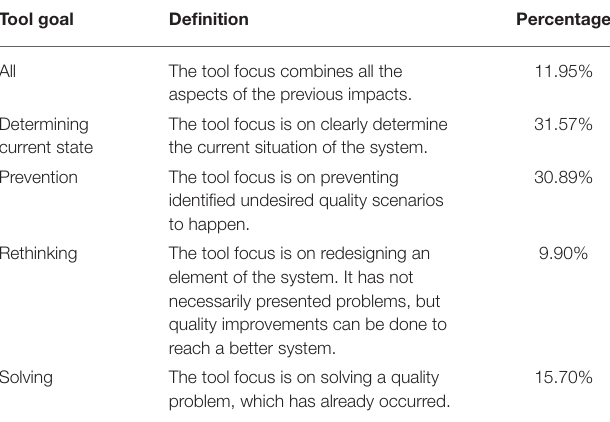
TABLE 7 | Definition of the different options of the second classification of tools on their goal. Tool